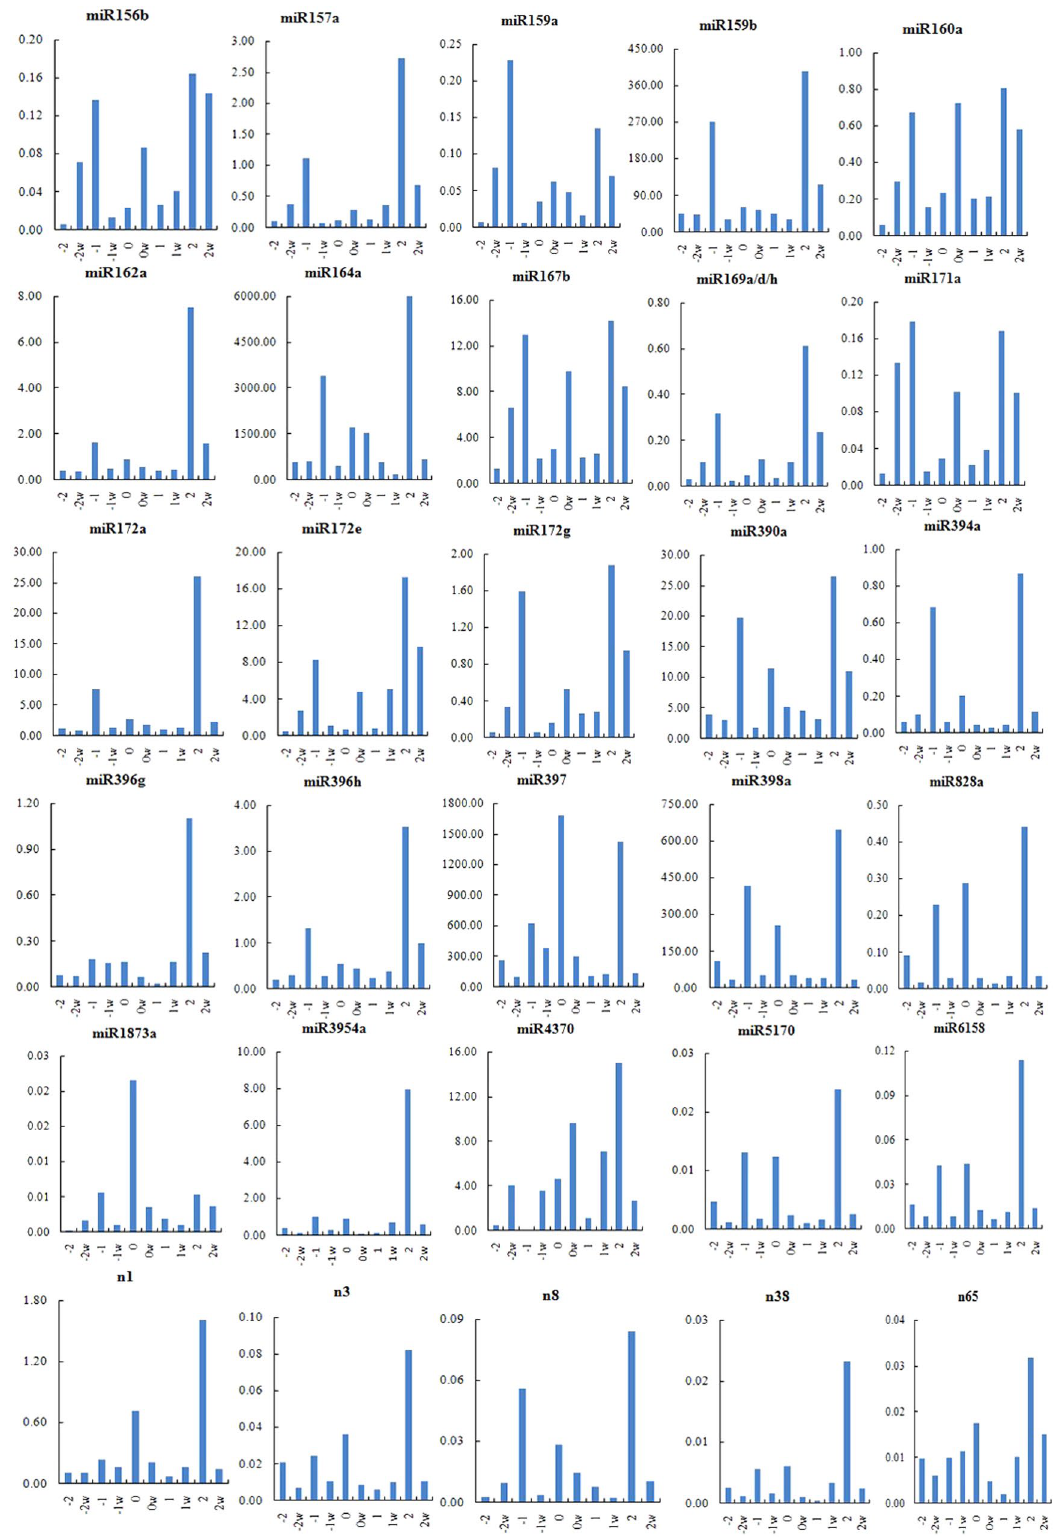
Figure 3. Among 54 tested miRNAs, many are differentially expressed between the cotton fiberless mutant Xu- 142-fl (marked as w in the figure) and its wildtype Xu-142. In this figure, only 30 miRNAs are presented with different development stages, which show significant expression between cotton fiberless mutant Xu-142-fl and its wildtype